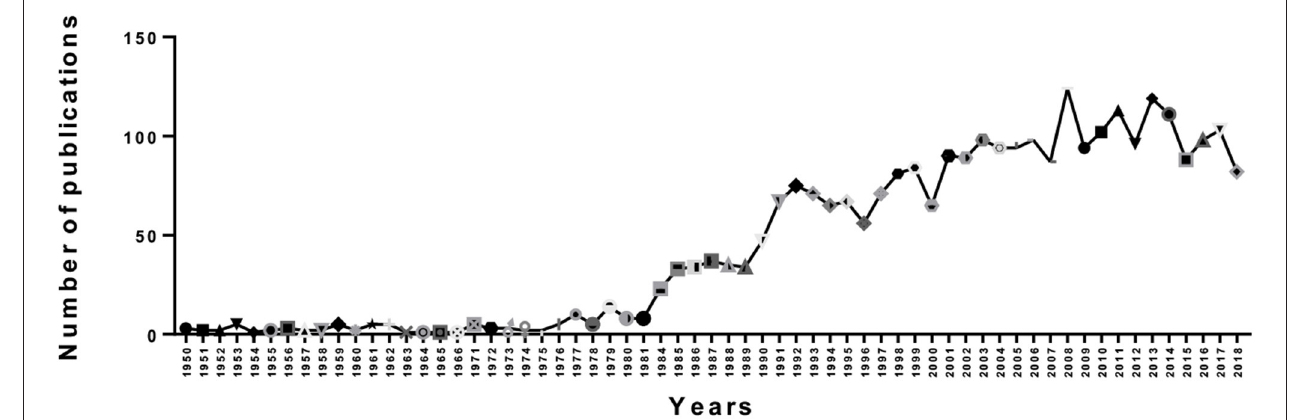
FIGURE 2 | The number of annual publications on PMS/PMDD research from 1950 to 2018.